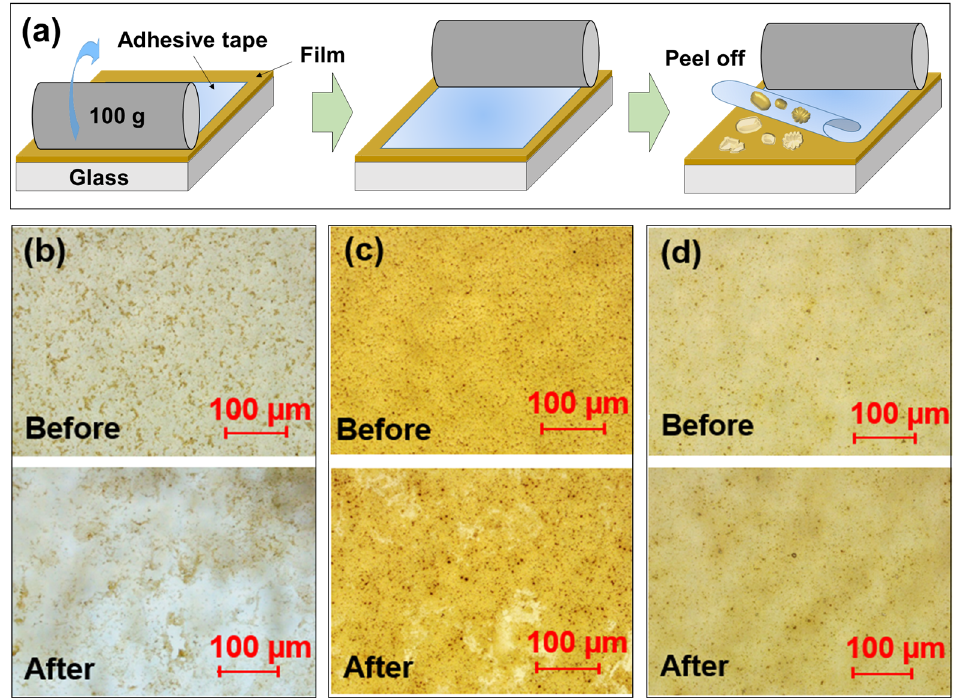
Figure 6. ( a ) Schematic diagram of peeling test and optical microscope images before/after peeling test on ( b ) pure TiO 2 , ( c ) TiO 2 ̶ KH550and ( d ) TiO 2 ̶ KH550 ̶ PEG films.